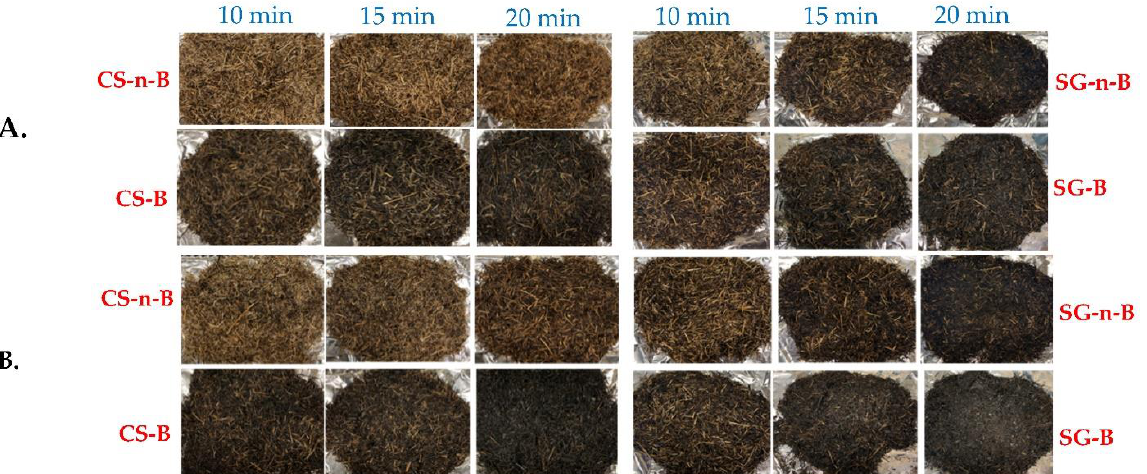
Figure 3. Microwave torrefied camelina straw and switchgrass with and without biochar ( A ) 520 W and ( B ) 650 W. CS-B: camelina straw with biochar; SG-B: switchgrass with biochar; CS-n-B: camelina straw-no-biochar; SG-n-B: switchgrass-no-biochar. The first number after the biomass is % of biomass, and the second number is % of biochar.